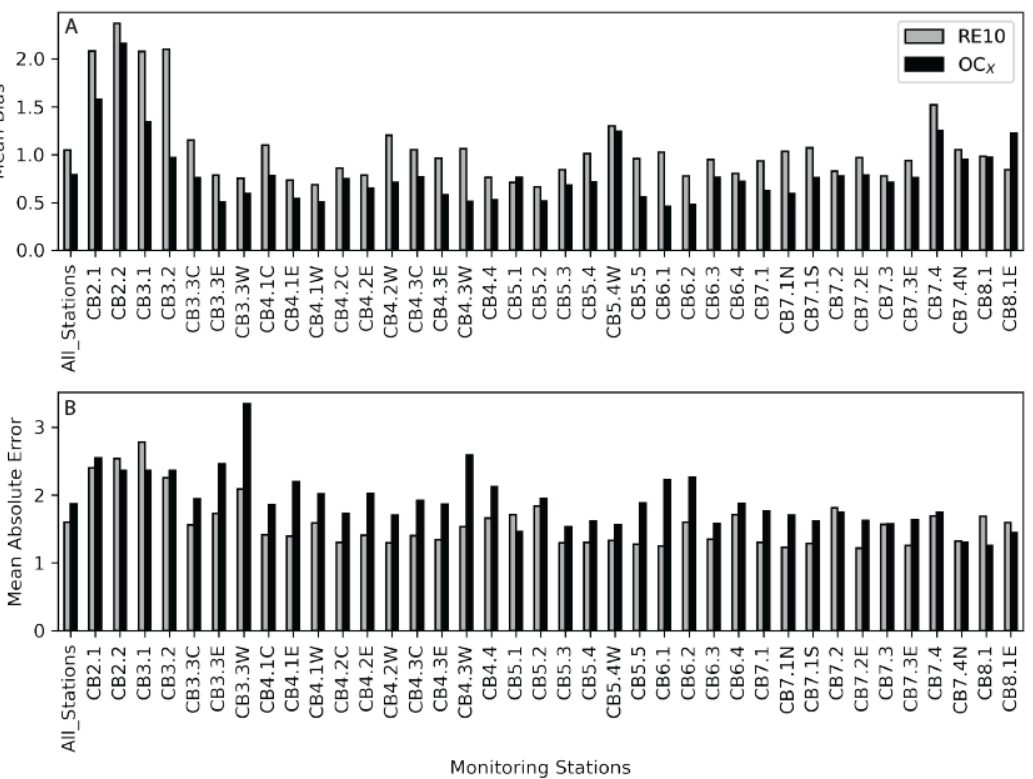
Figure 4. ( A ) Mean bias from the field data and the OLCI-RE10 (gray) and the OLCI-OC4 (black) imagery for each station from the Chesapeake Bay Program. The stations run from left to right and represent a transect from the head of the bay to the mouth (Figure 1). Values closer to 1 indicate less bias. ( B ) The Mean Absolute Error (MAE) is presented in the same fashion as the mean